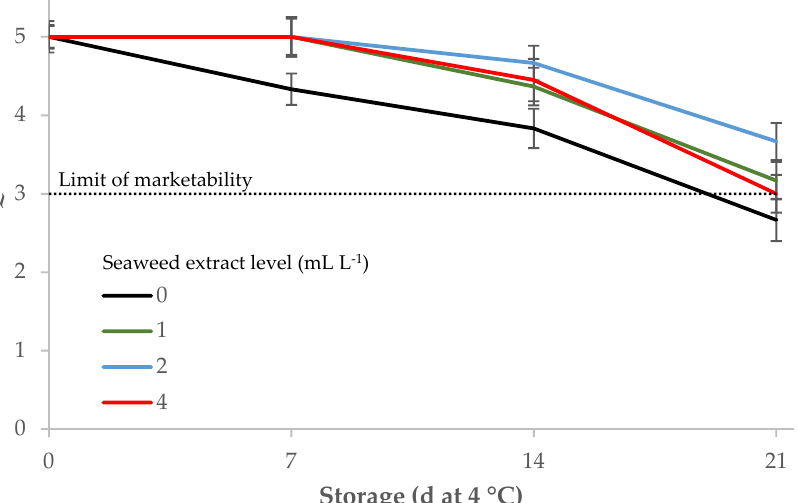
Figure 5. Influence of Ecklonia maxima extract levels in the nutrient solution and storage at 4 °C on the overall quality of fresh-cut leaf lettuce (1: unmarketable; 3: average—limit of marketability; 5: excellent or having a fresh appearance).